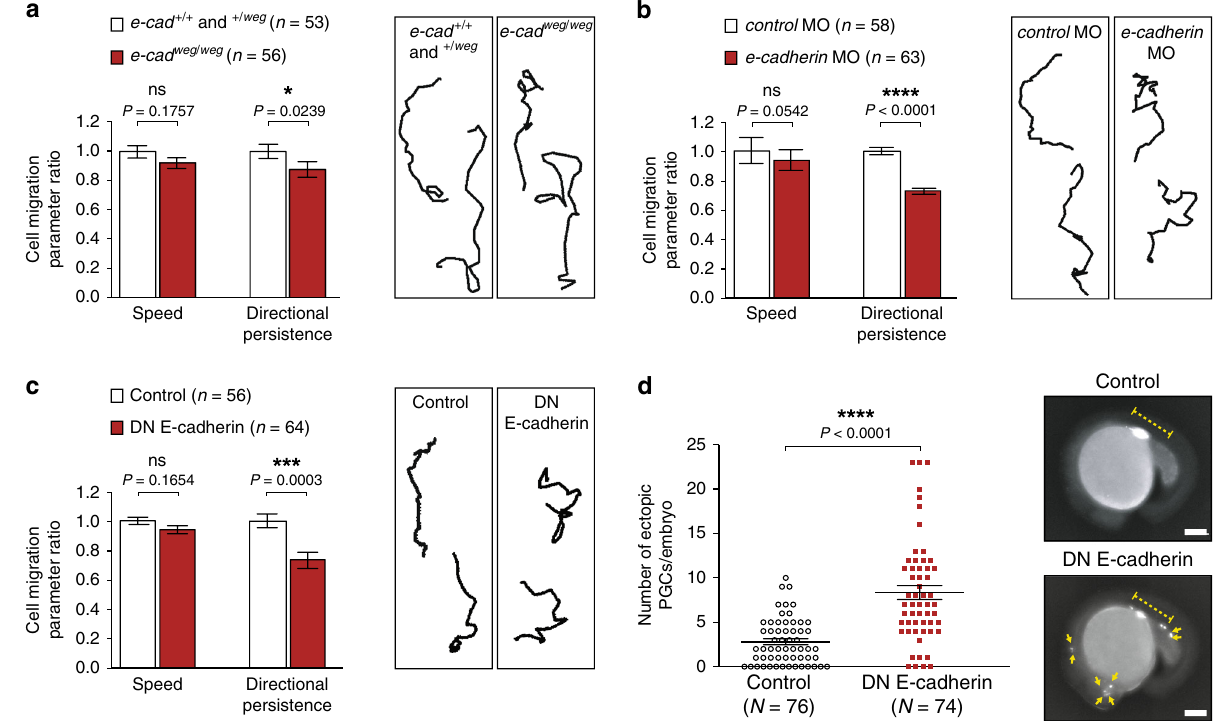
Fig. 1 E-cadherin is required for germ cell directionally persistent migration track. a Graph: PGC migration speed and directional persistence in e- cadherin weg/weg embryos relative to control embryos. n = number of cells from 4 independent experiments. Right: representative tracks of PGCs migrating within e-cadherin + / + and + / weg embryos or e-cadherin weg/weg embryos. b Graph: PGC migration speed and directional persistence in e-cadherin - morpholino-treated embryos relative to control embryos. n = number of cells from 4 independent experiments. Right: representative tracks of PGCs migrating within embryos injected with either a control or e-cadherin morpholino. c Graph: migration speed and directional persistence of PGCs expressing a dominant-negative form of E-cadherin as compared with control cells. n = number of cells from 3 independent experiments. Right: representative tracks of cells expressing a control protein or a dominant-negative form of E-cadherin. The results presented in a – c were derived from time-lapse movies captured between 6 and 8 hours post fertilization (hpf) at a time interval of 2 min between frames. The tracks are presented as 2-dimensional Z-projection of the 3- dimensional data acquired. Cells were tracked for 70 min and analyzed using Imaris software. Additional representative tracks are provided in Supplementary Fig. 1a. Normalized mean ± s.e.m.; P value: two-tailed Mann – Whitney U -test; ns = not signi fi cant. d Graph: number of cells that reside out of the developing gonad region at 22 hpf. Mean ± s.e.m.; P value: two-tailed Mann – Whitney U- test; N = number of embryos from 3 independent experiments. Right: Dashed yellow line indicates the developing gonad region, which spans the fi rst half of the yolk extension; yellow arrows point at ectopic cells; scale bars, 150 μ m. Source data are provided as a Source Data fi